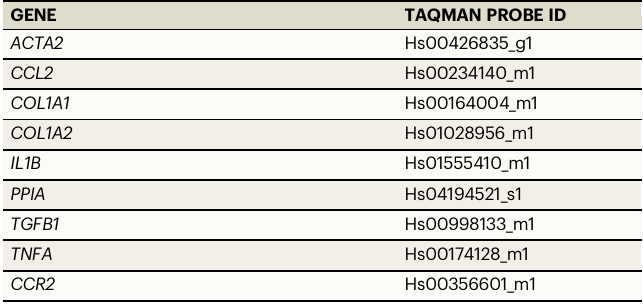
Table 2 | TaqMan ® probes used for RT-qPCR GENE